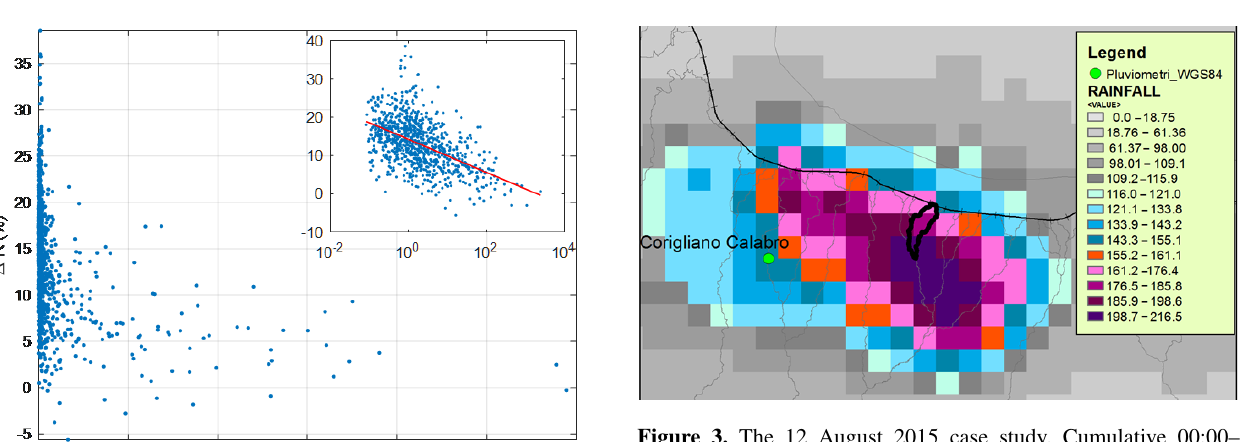
Figure 3. The 12 August 2015 case study. Cumulative 00:00– 08:00GMT radar rainfall (darker colours mean heavier rainfalls) and Corigliano rain gauge (green